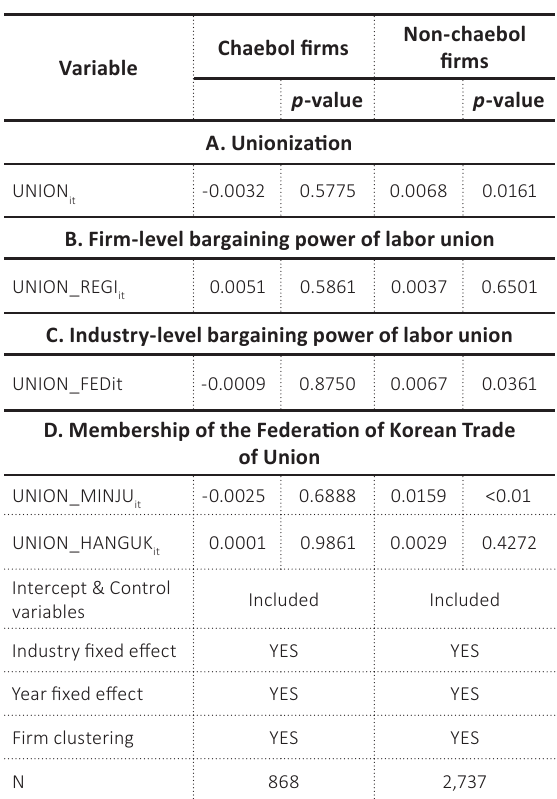
Table 4. The membership of the Federation of Korean Trade of Union and tax avoidance